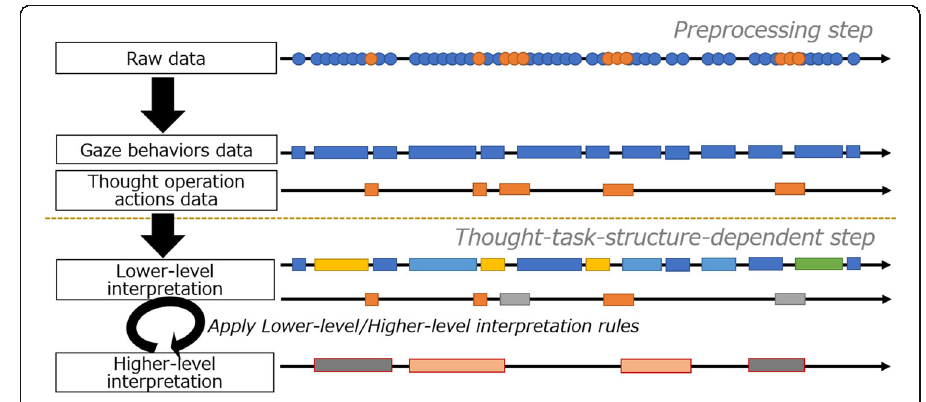
Fig. 4 Concept image of applying interpretation